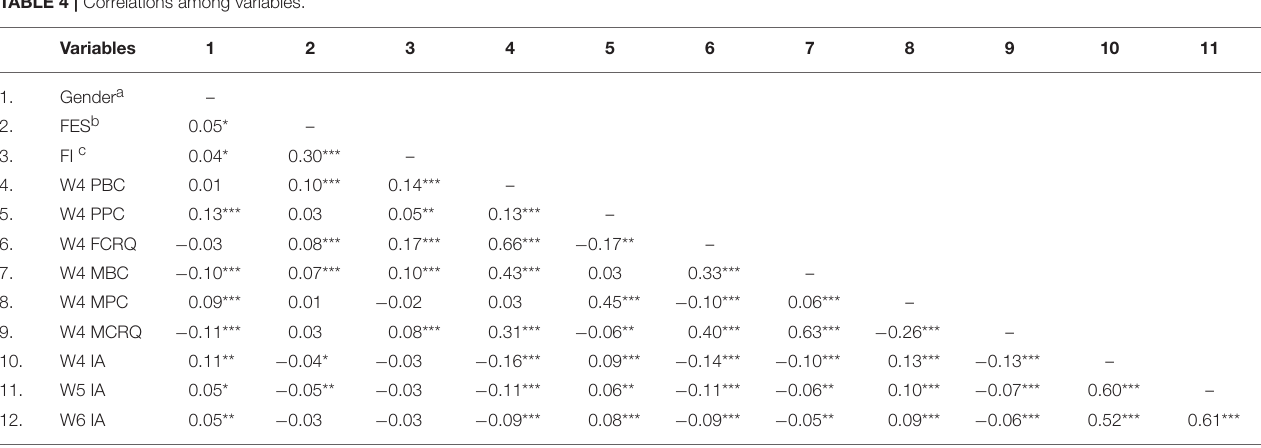
TABLE 4 | Correlations among